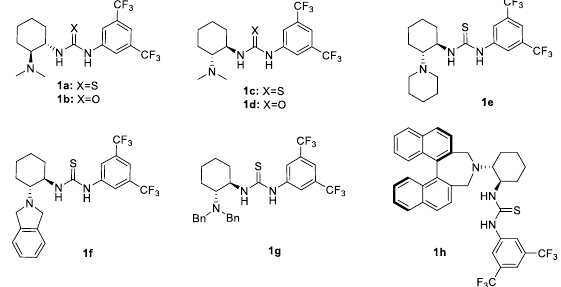
Figure 1. (Thio)urea derivatives screened as organocatalysts (1a – 1h).